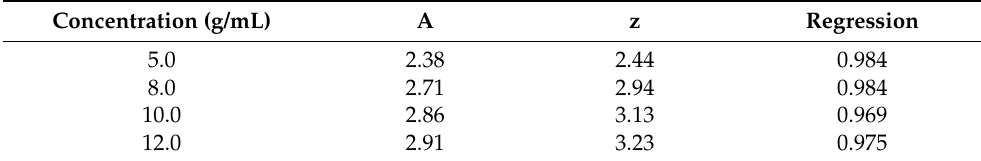
Figure 10. Log–log plots of complex moduli vs. frequency for PSFEtP + solutions at different concentrations. Table 3. Parameters specific to dynamic complex moduli highlighting the sol-gel transition.